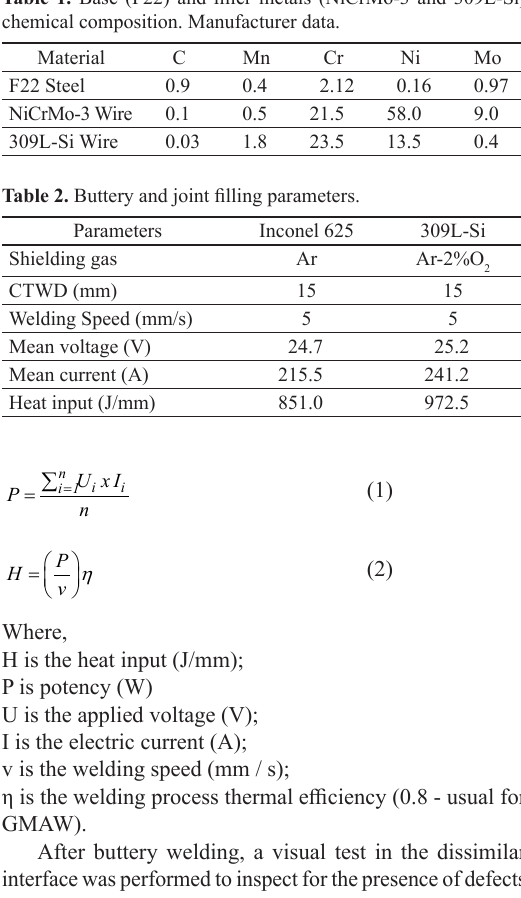
Figure 1. Cross-section macrograph of 8630 - Inconel 625 dissimilar joint 5 .